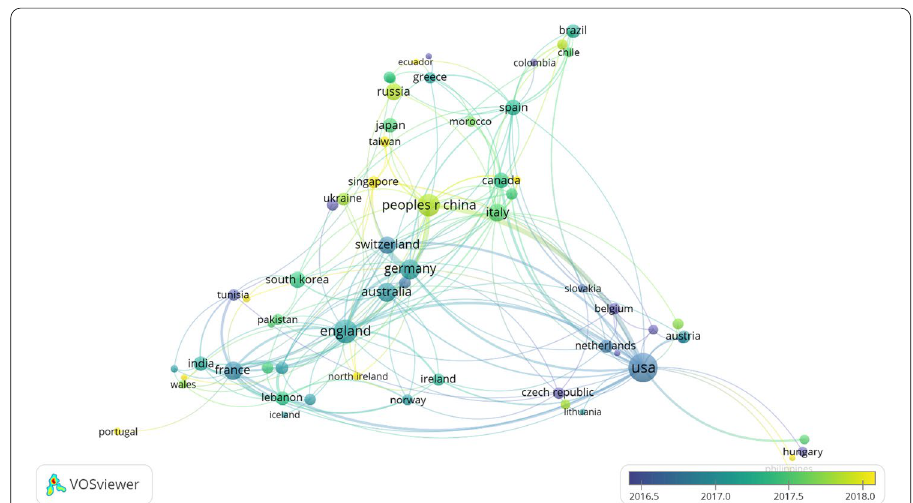
Fig. 5 Grouping by country and year. Source : Own compilation